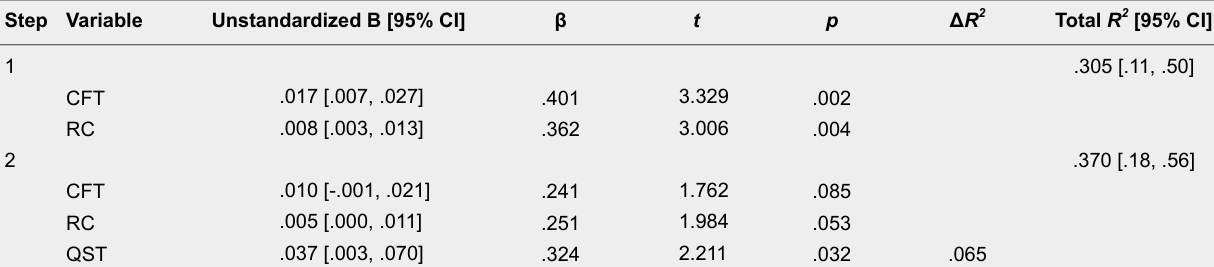
Hierarchical Regression Analyses Predicting Third Grade Mathematics Achievement Test (MAT)